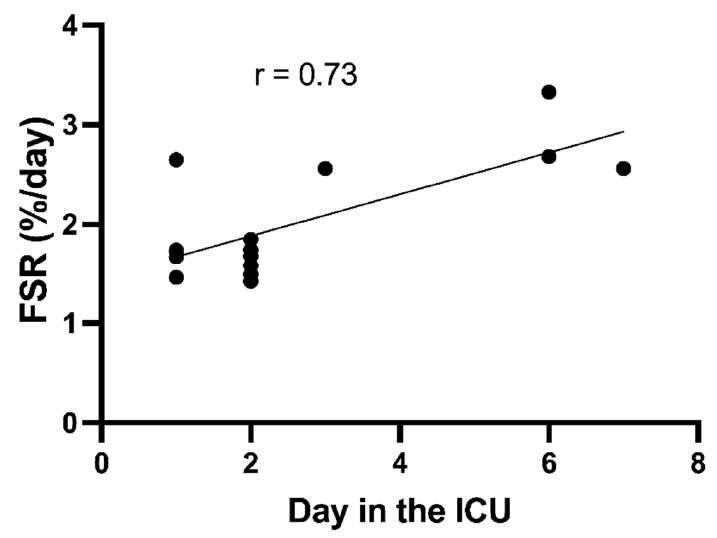
Figure 2. Correlation between mean in the fractional synthesis rates (FSRs) of skeletal muscle mixed protein and the days of ICU stay when patients were studied ( n = 17) using regression analysis ( top ). The correlation was also calculated with the two obvious long-stayers excluded ( bottom ).